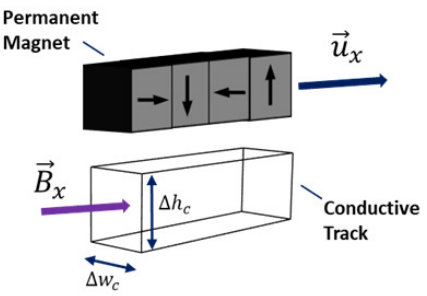
Figure 7. Geometrical representation of the magnet’s magnetic field in the x -direction traveling through a cross-section of the conducting track.